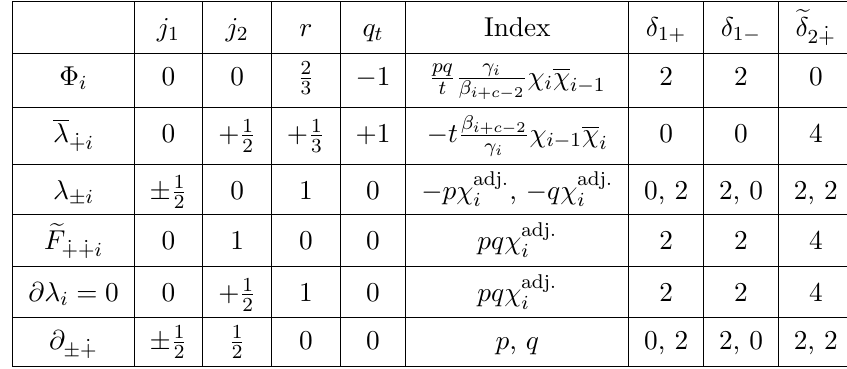
Table 5. Letters satisfying the BPS condition (4.4) of the free N = 1 theory corresponding to a tube which implements the Φ -gluing of two punctures of equal colour, opposite orientation and sign σ = + . For the vector multiplet piece we must take into account the equation of motion ∂λ = ∂ λ − + ∂ λ + = 0 . Here χ i ≡ χ + ˙+ − ˙+